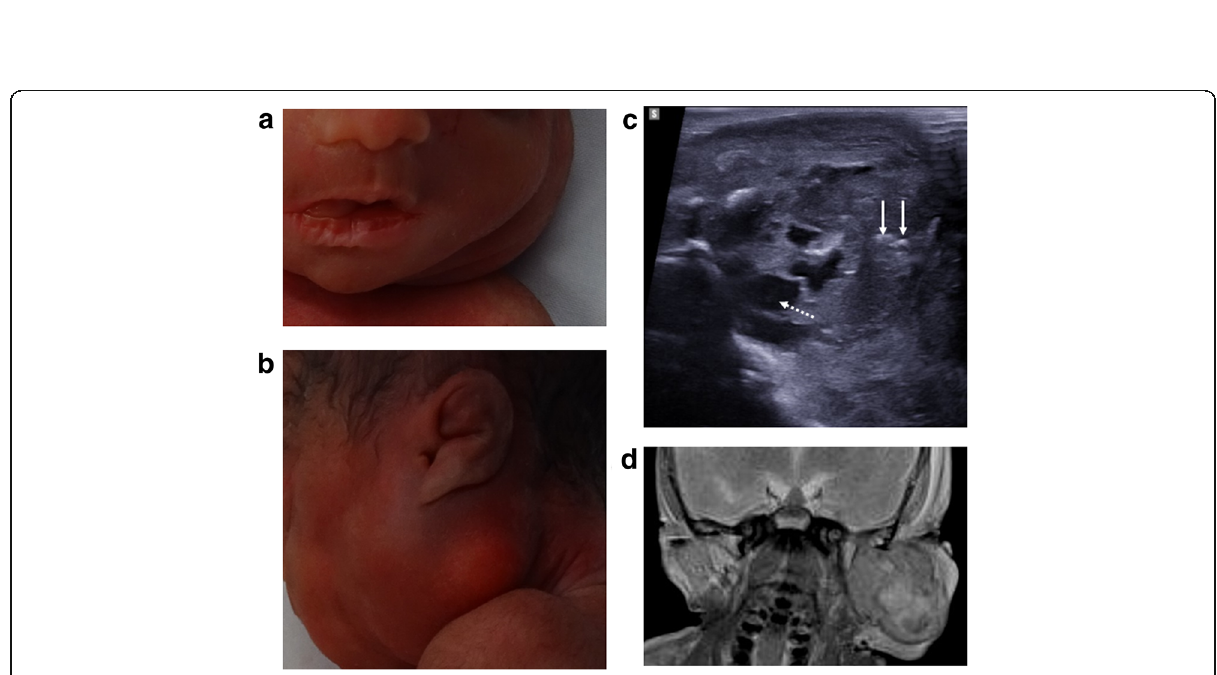
Fig. 8 Post-mortem images of a foetus at 25 weeks gestation with a prenatally detected neck mass. Post-mortem photographs at external examination from the front ( a ) and of the left side of the neck ( b ) demonstrate the soft tissue neck mass. The post-mortem ultrasound ( c ) was performed 2 days after delivery and demonstrated mixed solid and cystic elements with some internal calcific foci in this lesion. The subsequent post-mortem MRI ( d ) performed on the same day confirms the ultrasound findings of a solid and cystic mass, although it was harder to demonstrate the internal calcific foci. At histopathological assessment, the mass was found to represent a